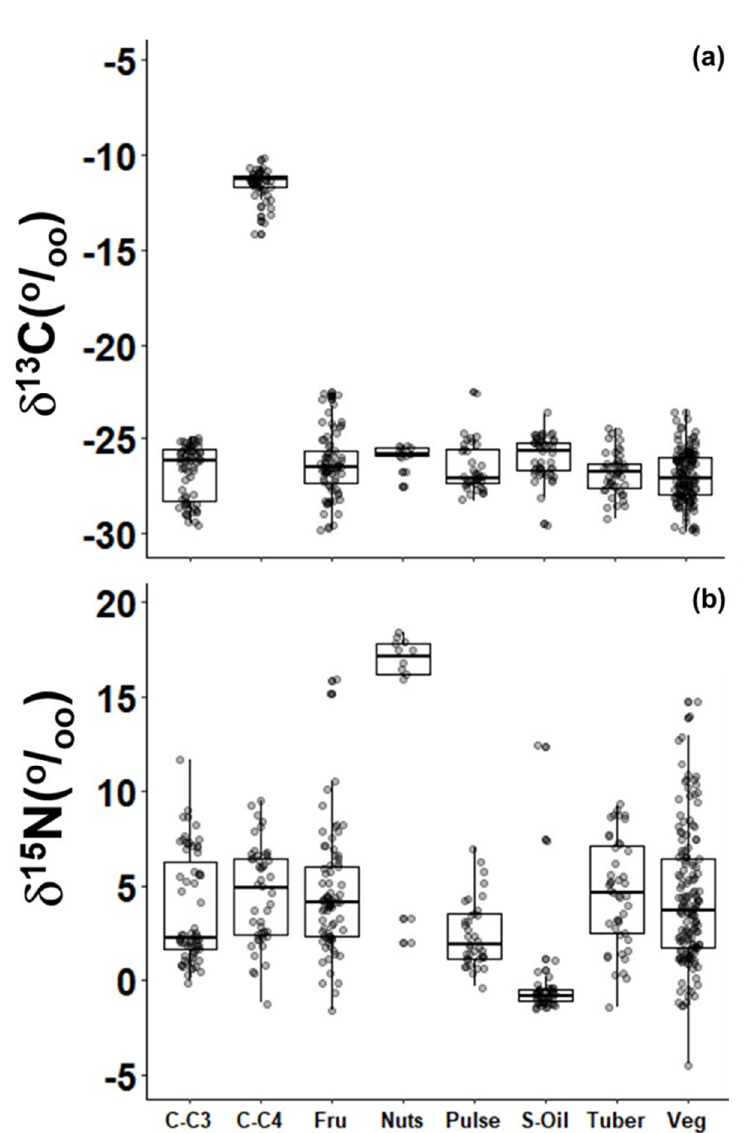
Figure 2. Box-whisker of δ 13 C ( a ) and δ 15 N ( b ) of in natura plants used as food in Brazil grouped according to the FAO classification. C-C 3 : cereals that follow the C 3 photosynthetic metabolism (wheat and rice); C-C 4 : cereals that follow the C 4 photosynthetic pathway (maize); Fru: fruits; Nuts: nuts; Pulse: pulses; S-Oil: oilseeds; Tuber: tubers; Veg: vegetables. See the Supplementary Material for food items included in each of these groups.